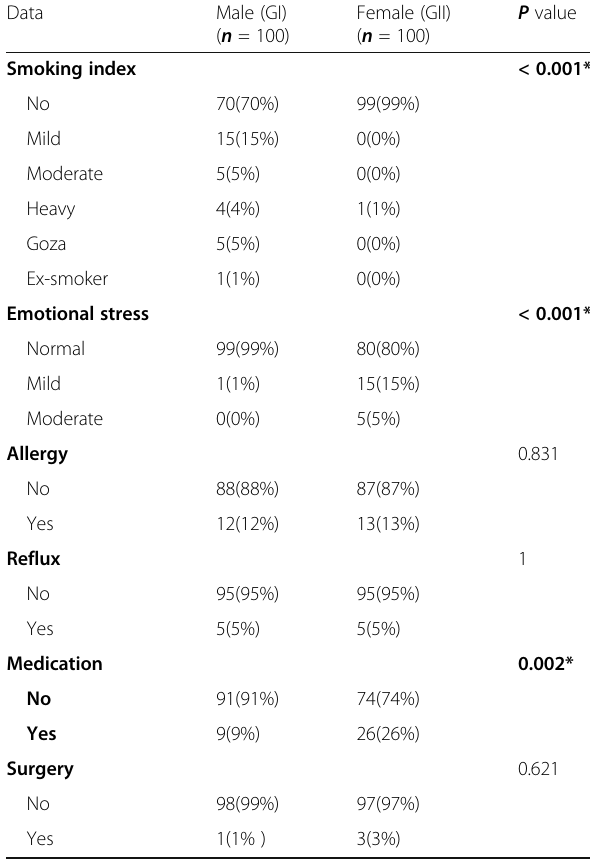
Table 6 Comparison between male and female teachers regarding etiological